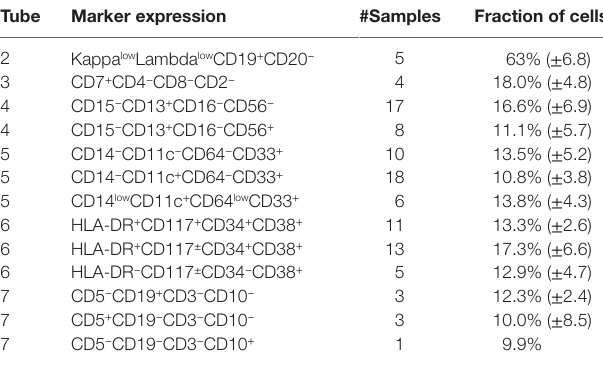
TaBle 2 | some of the meta-clusters characteristic of aMl for the 23 aMl samples in the training set. Tube Marker